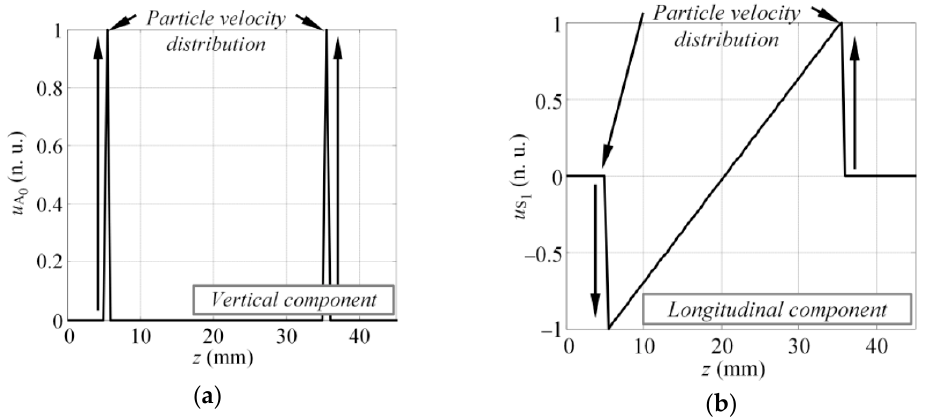
Figure 2. The presumed spatial distribution of the particle velocity of the MFC transducer on the excitation surface: the vertical or normal component, which mainly generates the A 0 mode ( a ) and the longitudinal or tangential component, which produces the S 1 mode ( b ).